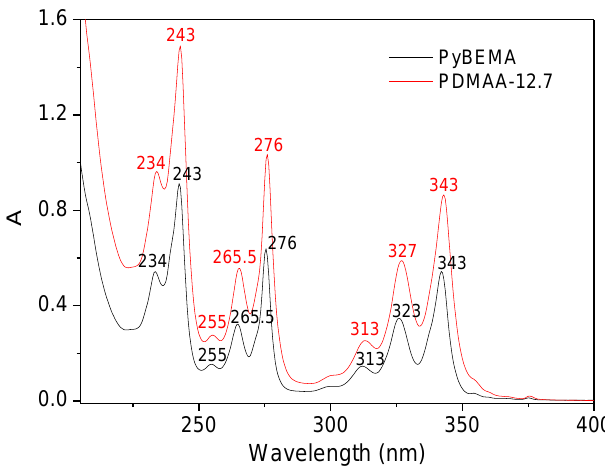
Figure 1. UV absorption spectra of PyBEMA monomer and PDMAA-12.7 copolymer in ethanol.